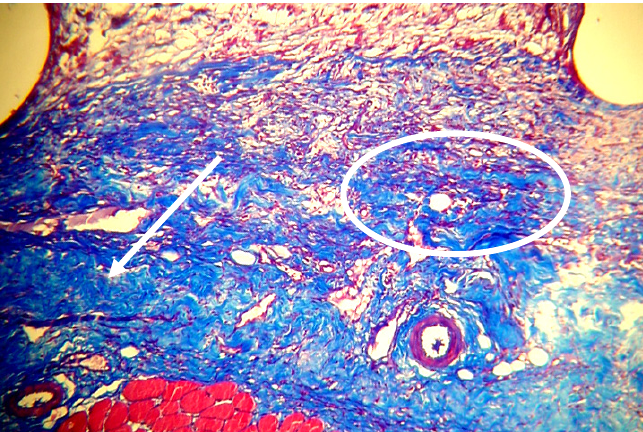
FIGURE 6 – Light photomicrograph of the left inguinal region of dog number 1 (prolene) obtained on the 7th postoperative day. The presence of fibrosis is observed (circle) and the prolene prosthesis is fully incorporated into adjacent tissues (arrow). (Masson trichrome,